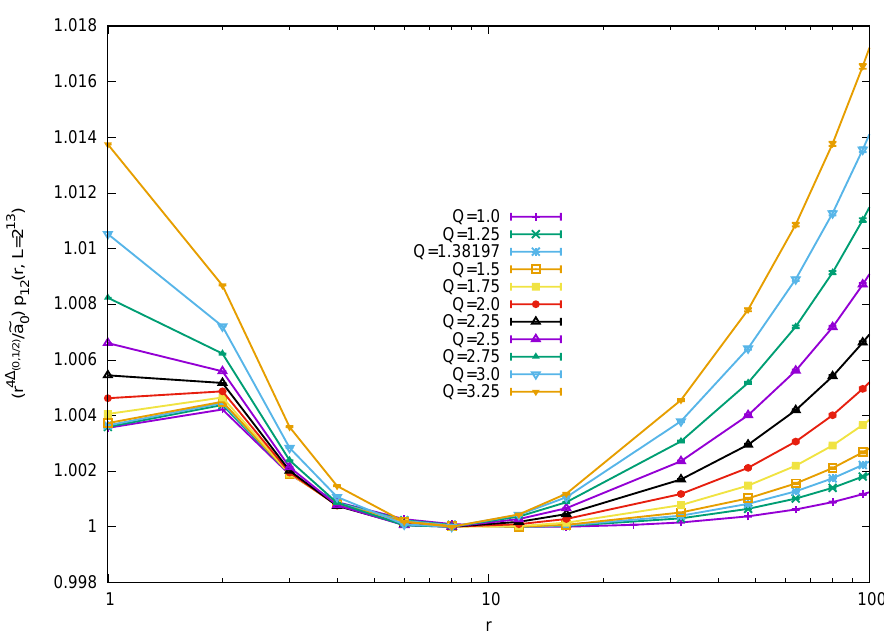
Figure A.1: Monte-Carlo measurements of the two-point connectivity as a func- tion of the distance r between the two points. The plot shows the function 4 ∆ ( 0,1 1 ( r , L = 2 13 ) , for r = 1,2,4,8, (cid:1)(cid:1)(cid:1) , L ) p r 2 12 ˜ a 0 defined in the text, takes values close to the a